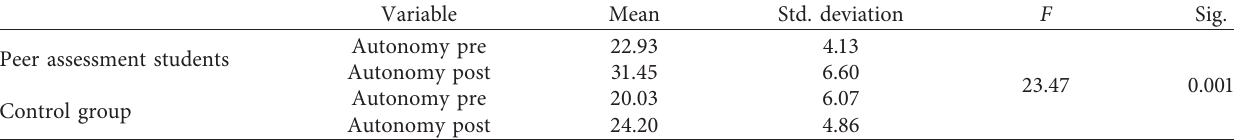
Table 4: Results of covariance for autonomy variable in peer-assessment